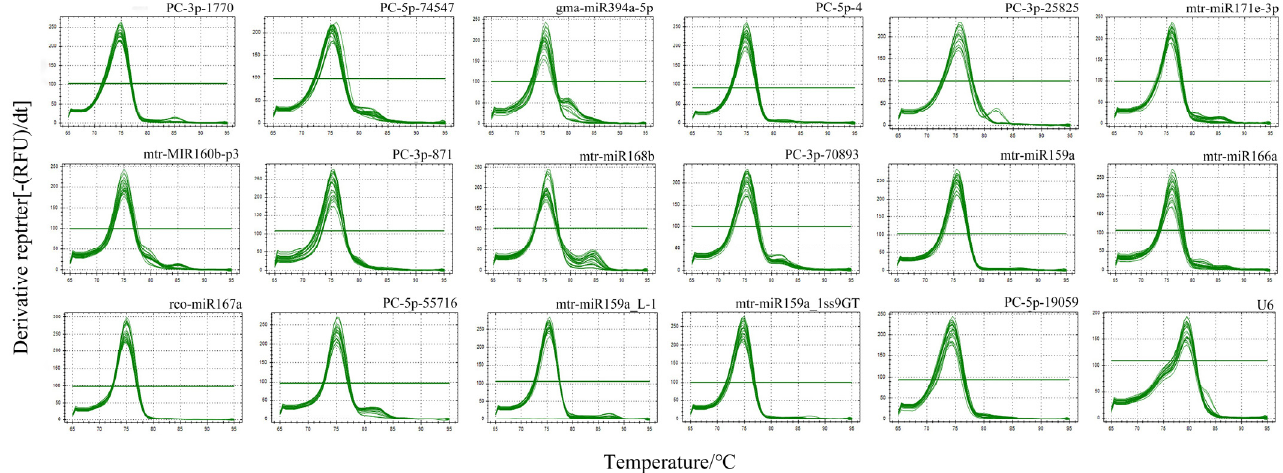
Figure 3. Dissolution curve of primers by qRT-PCR.